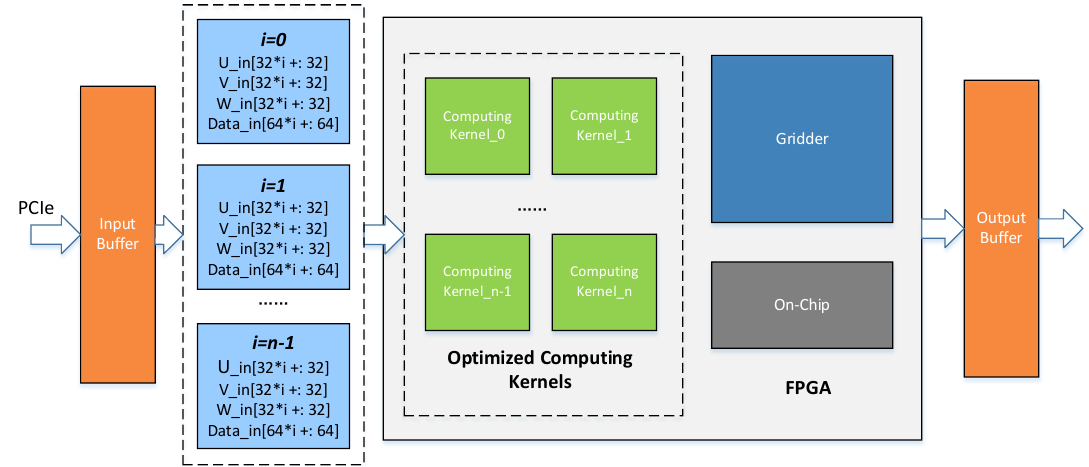
Figure 9. Overall optimized structure of the phase rotation algorithm.